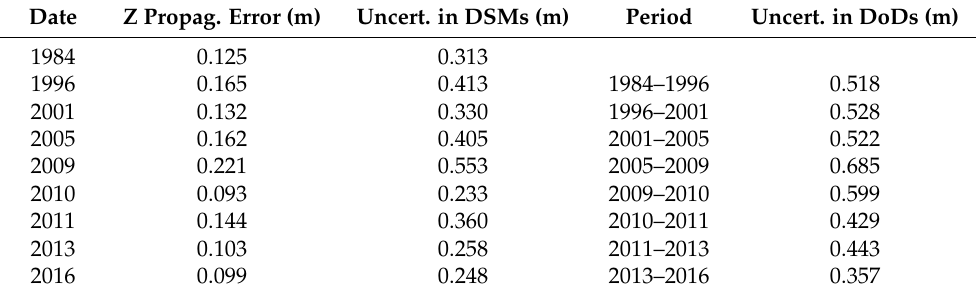
Table 3. Uncertainties in DSMs and